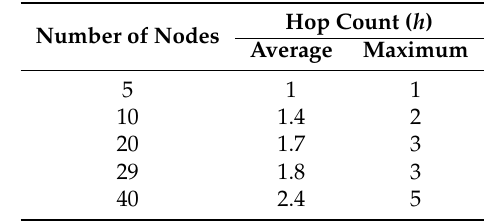
Table 7. Characteristics of the WSNs used in congestion control experiments on w-iLab.t Zwijnaarde wireless sensor